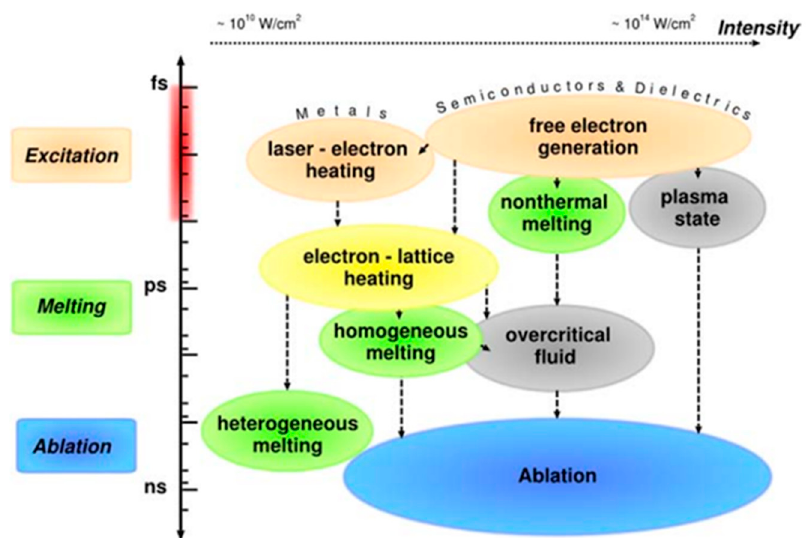
Figure 2. Typical timescales and intensity ranges of several phenomena and processes occurring during and after irradiation of a solid with an ultrashort laser pulse of about 100 fs duration [27].